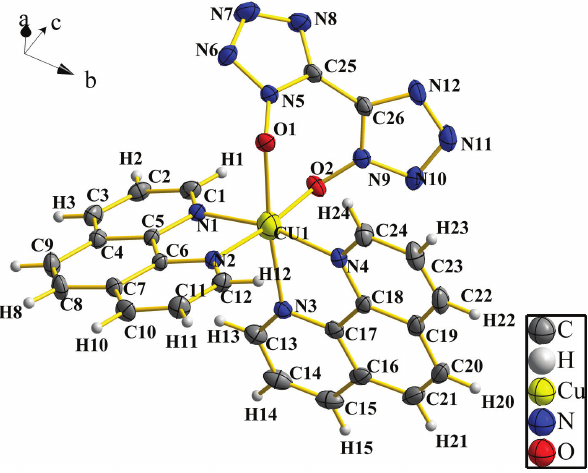
Table 2: Fractional atomic coordinates and isotropic or equivalent isotropic displacement parameters (Å 2